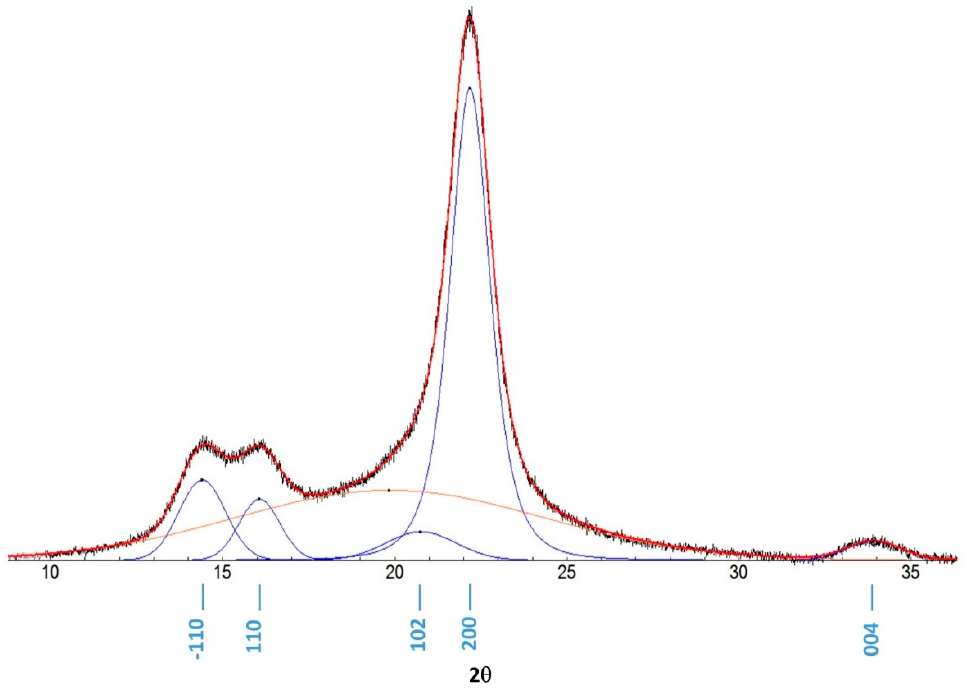
Figure 3. XRD peak deconvolution of CLC: the black line is the experimental diffractogram, the red line is the total fitting, the blue Gaussian peaks represent the main reflections and the orange Gaussian curve represents the amorphous region.